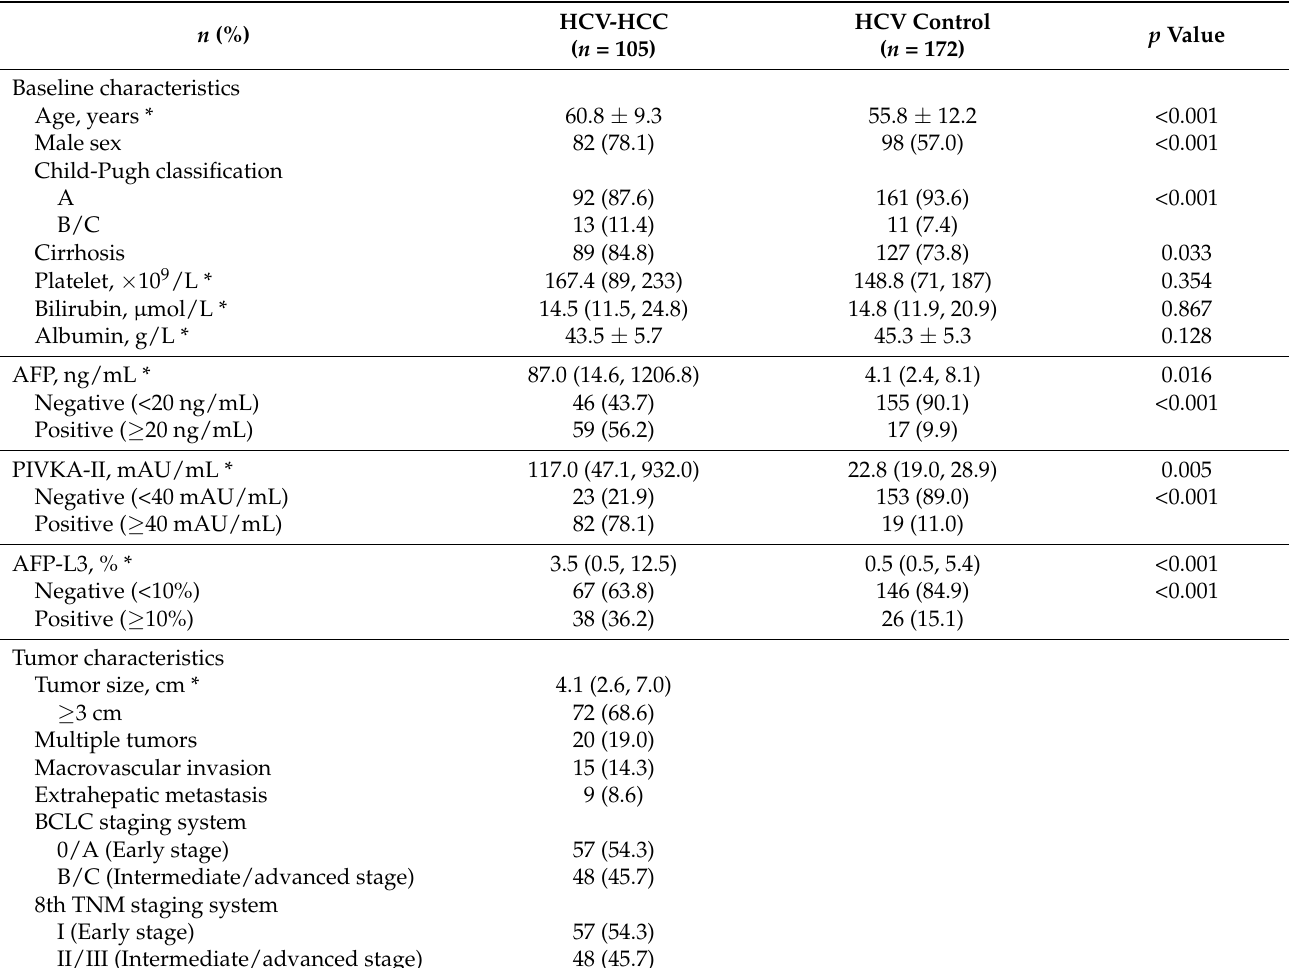
Table 1. Comparisons of clinical characteristics between the HCV-induced HCC and HCV-control